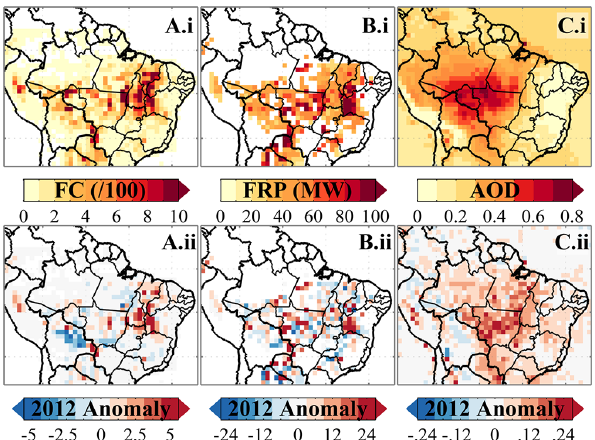
Figure 5. September 2008–2017 median total fire count (FC; a ) and fire radiative power (FRP; b ) from MODIS active fire detections, calculated over a 1 ◦ grid. The FC scale is divided by 100 for figure clarity. September 2008–2017 median aerosol optical depth (AOD; c ) from MODIS 1 ◦ product. The 2012 anomaly for each of these fields is illustrated in panels (ii) .